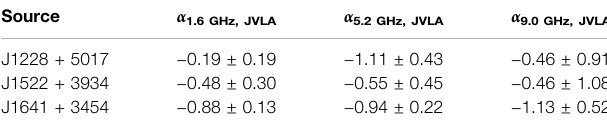
TABLE 4 | Traditional spectral indices calculated using the peak fl ux